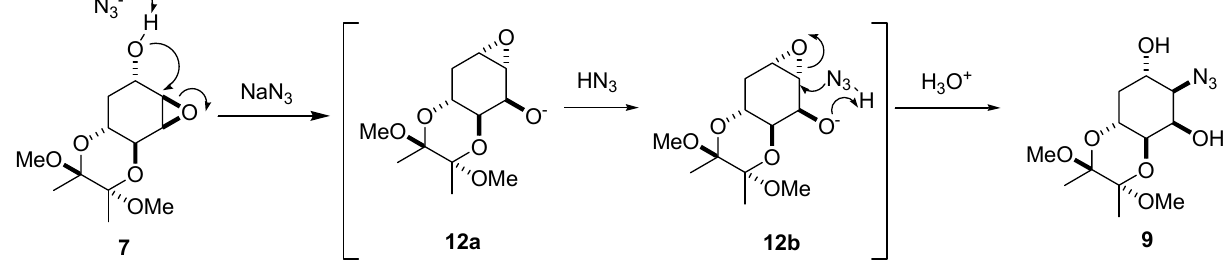
Figure 3. Plausible mechanism for the formation of 9 .